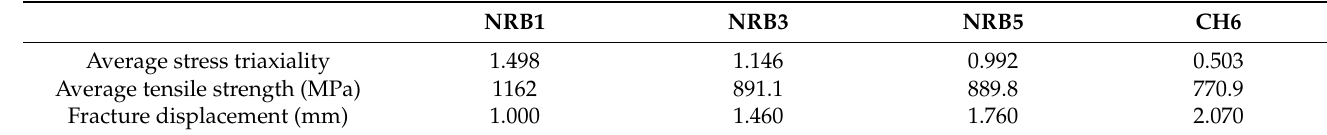
Table 4. Average stress triaxiality and tensile strength of notched specimens.